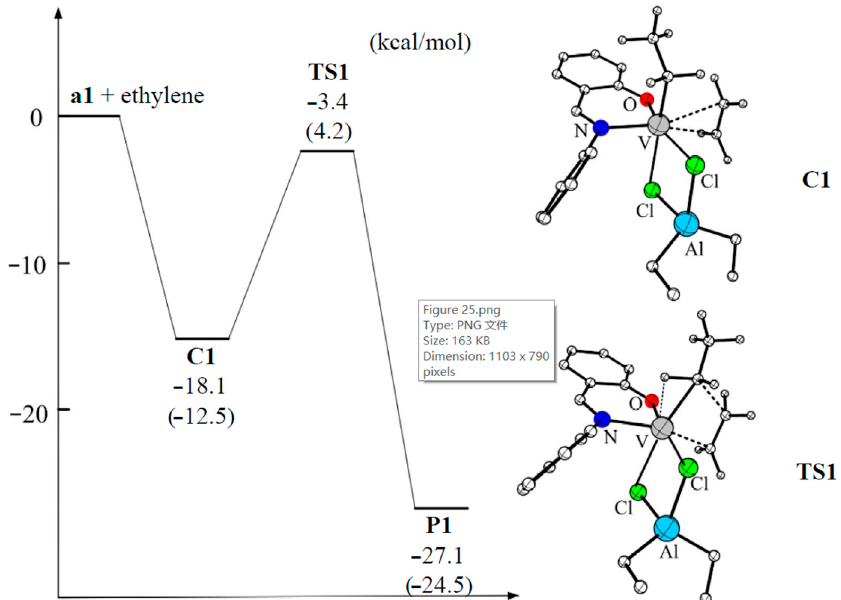
Figure 25. Potential energy surface and optimized geometries of the π -complex and transition state of the ethylene insertion catalyzed by the active species V04 . The energy was calculated at the M06-L functional level, with energy changes calculated at the B3LYP-D3 functional level given in parentheses. Reprinted with permission from [211]. Copyright (2015) Elsevier B.V.